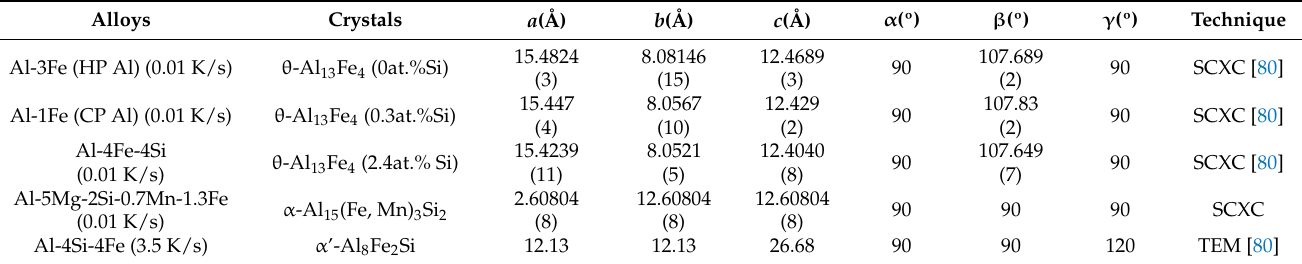
Table 4. Measured crystal lattice parameter of FIMC